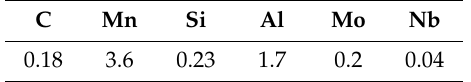
Table 1. Chemical composition (wt%) of the analyzed